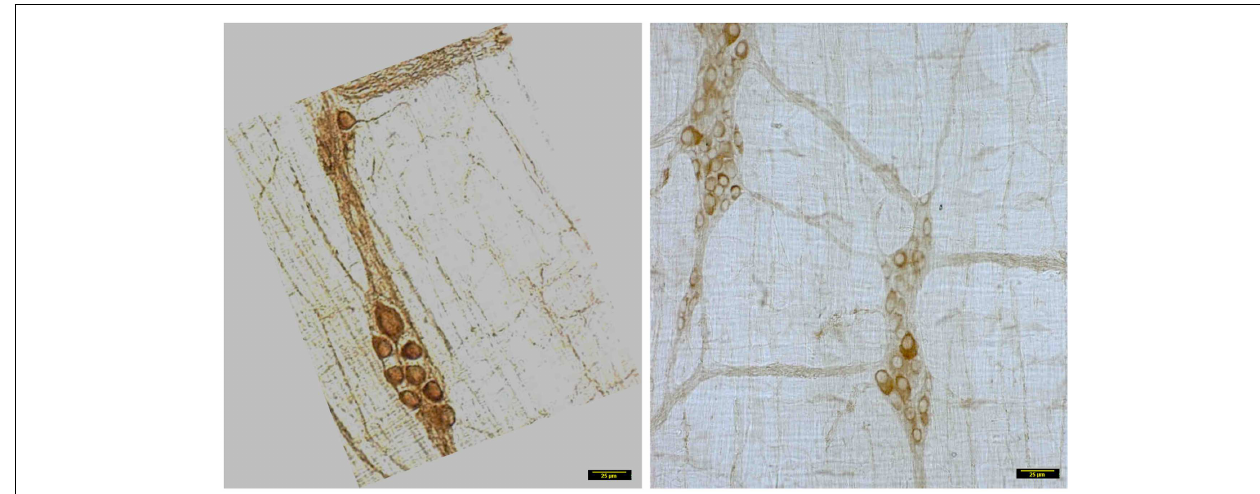
ganglion. In contrast, note that in the diabetic rats, despite the presence of secondary plexus linking the ganglia and tertiary extensions of nerve processes into the muscle layers, the brown DAB reaction product representative of myosinVa presences is scant or nearly absent in these processes. Scale bar, 25 µ m.